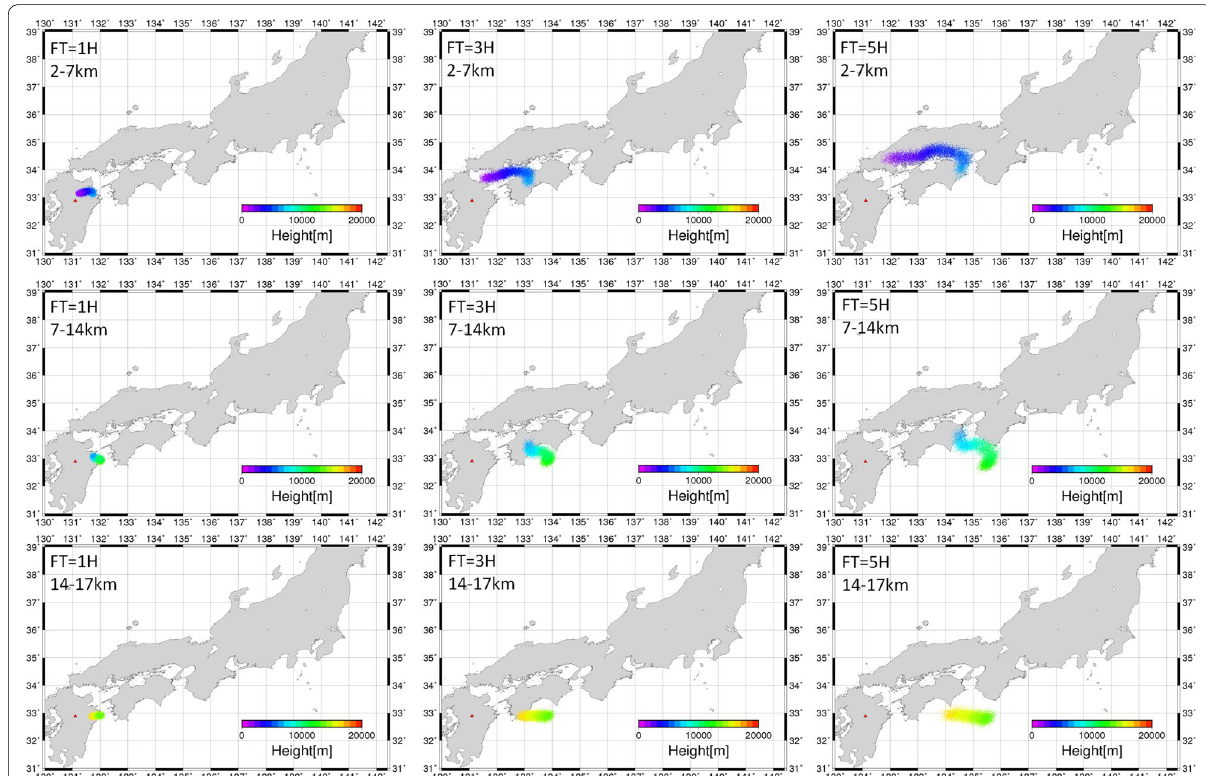
Fig. 4 Results of the SO 2 simulations by JMA-GATM. Upper row: simulation from initial altitude of SO 2 at 2–7 km. Middle row: simulation from initial altitude of SO 2 at 7–14 km. Bottom row: simulation from initial altitude of SO 2 at 14–17 km. The left column is approximately 1 h after eruption (02:46JST). The center column is approximately 3 h after eruption (04:46JST). The right column is approximately 5 h after eruption (06:46JST). The color bar indicates the height [m] of SO 2